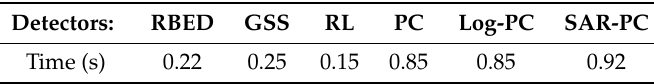
Table 1. Running time of each